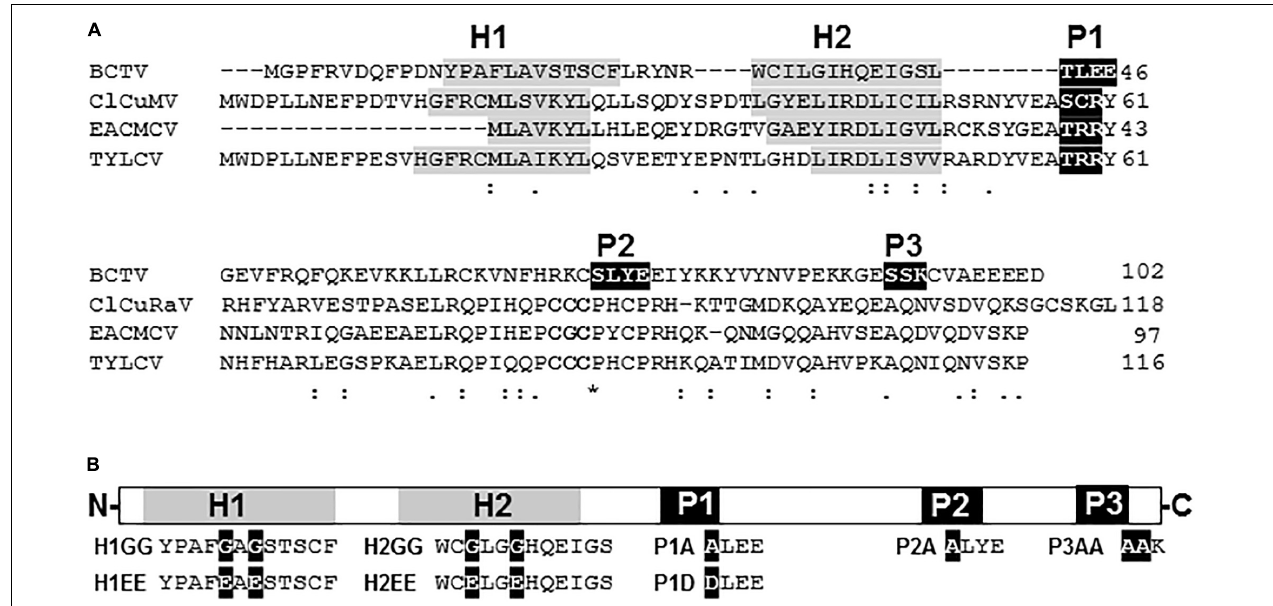
FIGURE 1 | V2 sequence from curtovirus and begomovirus. (A) Alignment of the aminoacid sequences of the V2 proteins from the curtovirus Beet curly top virus (BCTV; M24597) and the begomoviruses, Cotton leaf curl Multan virus (CLCuMV-Fai[PK:Fai2]; AJ496287), East African cassava mosaic Cameroon virus (EACMCV; AF112354) and Tomato yellow leaf curl virus (TYLCV; X15656). Gaps (-) were introduced to optimize the alignment. The positions of the predicted putative phosphorylation motifs P1 (protein kinase CK2/protein kinase C), P2 (protein kinase CK2) and P3 (protein kinase C) are depicted in white letters inside black boxes. The CxC motif from begomoviruses (Padidam et al., 1996; Zrachya et al., 2007) is underlined. The hydrophobic domains (H1 and H2) are shadowed in gray. (B) Schematic view of BCTV V2 aminoacidic sequence. Hydrophobic domains (H1 and H2) are depicted as gray squares. Putative phosphorylation motifs (P1, P2 and P3) are presented as black squares. Amino acid substitutions for each mutant (H1GG, H1EE, H2GG, H2EE, P1A, P1D, P2A, and P3AA) are indicated as white letters in black